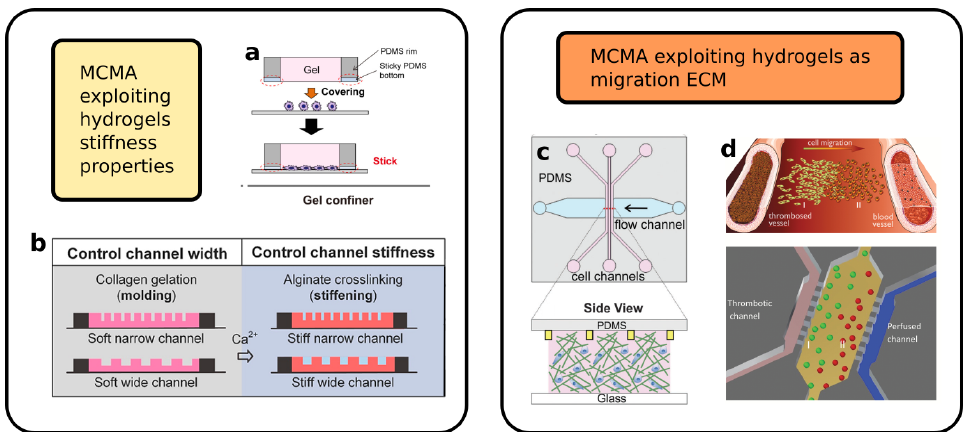
Figure 4. Examples of microfluidic migration assays realized with hydrogels:( a ) Hydrogel lid used to apply controlled mechanical load on migrating cells (Reprinted with permission from Ref. [63] Copyright 2021, Choi et al.); ( b ) Microchannels array with different size and stiffness